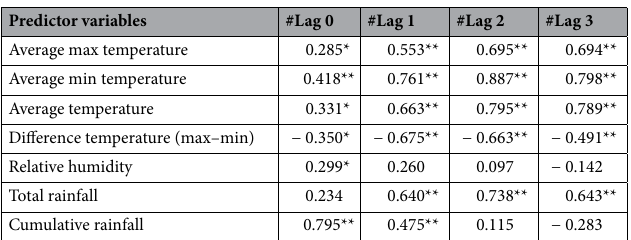
Table 2. Spearman’s rank correlations of environmental variables with dengue cases. * < 0.05, ** < 0.01, #Lag time (in months) of environmental variables and reported dengue cases in the current month.